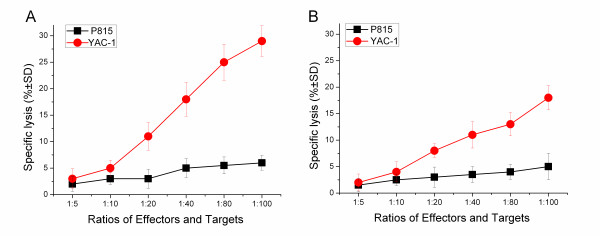
Splenic NK cytotoxicity after L. monocytogenes infection. C57BL/6 mice were infected with L. monocytogenes in the Se-adequate or Se-deficient state. At 72 h post infection, splenocytes were obtained from each group mice, and their ability to kill NK-sensitive YAC-1 target cells, and NK-insensitive P815 target cells was determined by 51Cr-release assay. Percentage-specific killing ± SD at the various ratios of effectors and targets are indicated for spleen cells from infected Se-adequate (A) and infected Se-deficient mice (B).